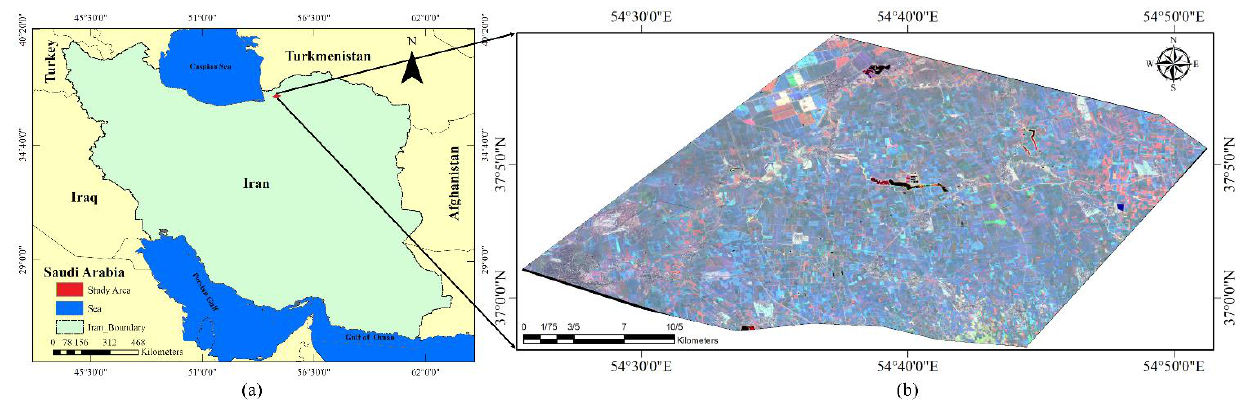
Figure 1. ( a ) The geographical location of the study area, and ( b ) a false-color composite NDVI image (R: first month NDVI, G: second month NDVI, and B: third month NDVI) from the study area.